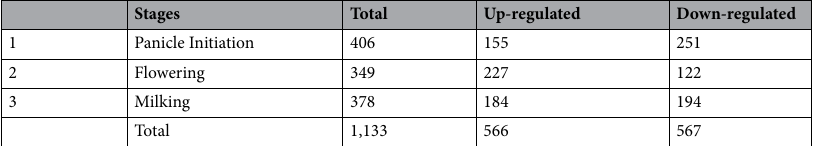
Table 4. Differentially Expressed Genes (DEGs) in pearl millet genotypes during different stages of panicle developmental and in high Fe and Zn containing pearl millet